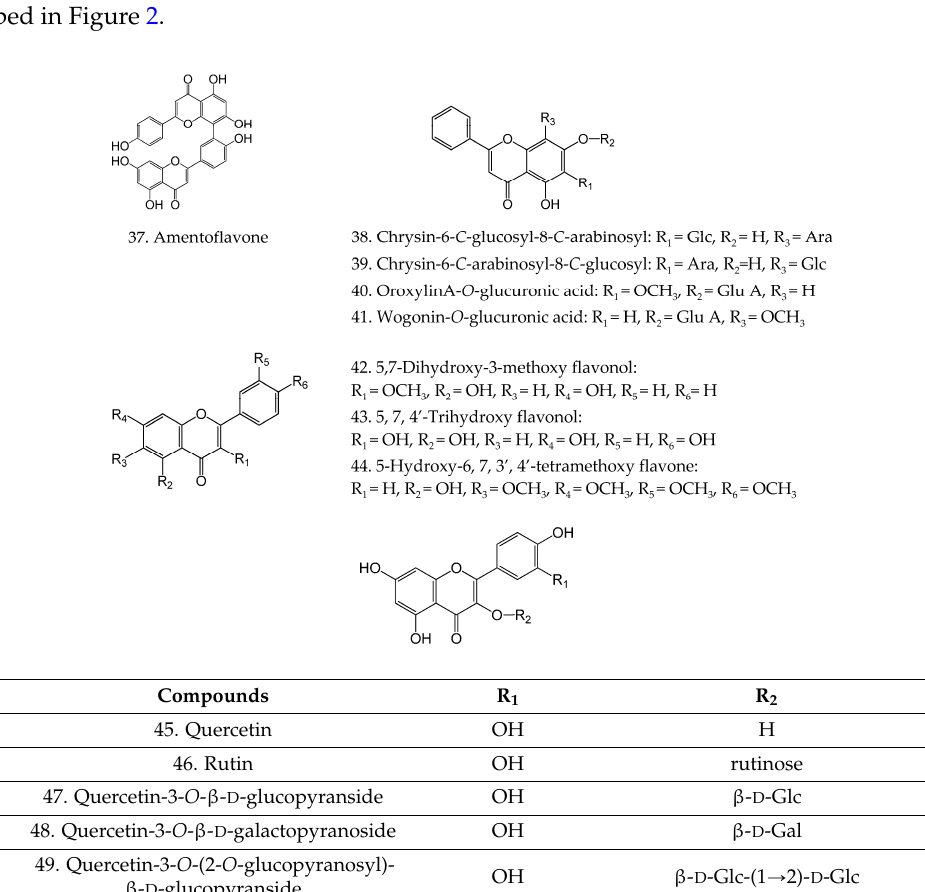
Figure 1. Chemical structures of iridoids and triterpenes in H. diffusa .